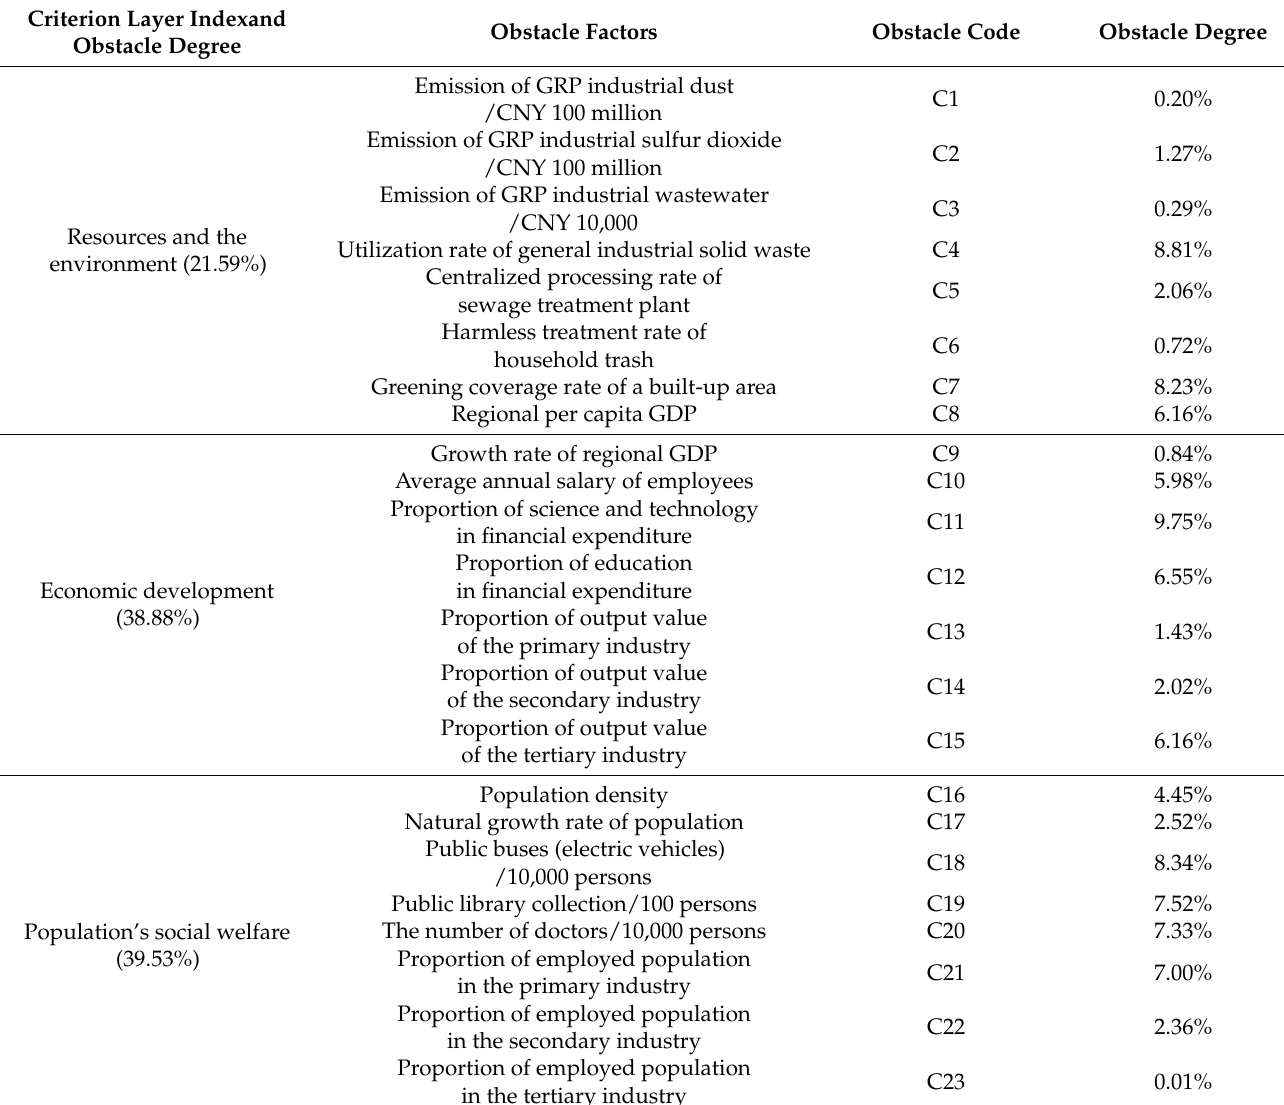
Table 13. Obstacle factors and degree of green development of coal-resource-exhausted